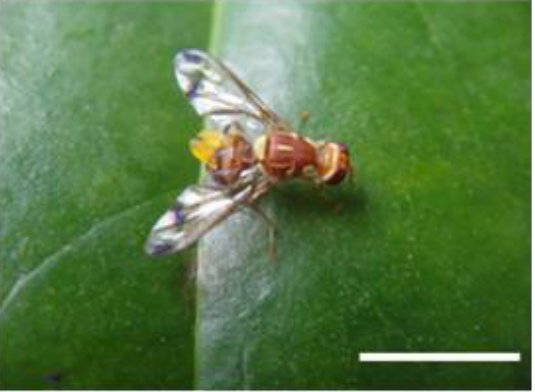
F IGURE 7. Pollinia of Bulbophyllum praetervisum on abdomen of the melon fly. Bar: 1 cm